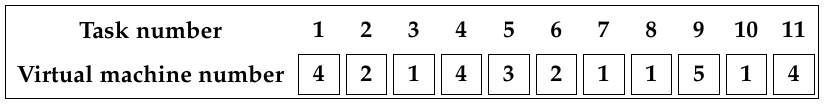
Figure 6. Assignment of tasks to virtual